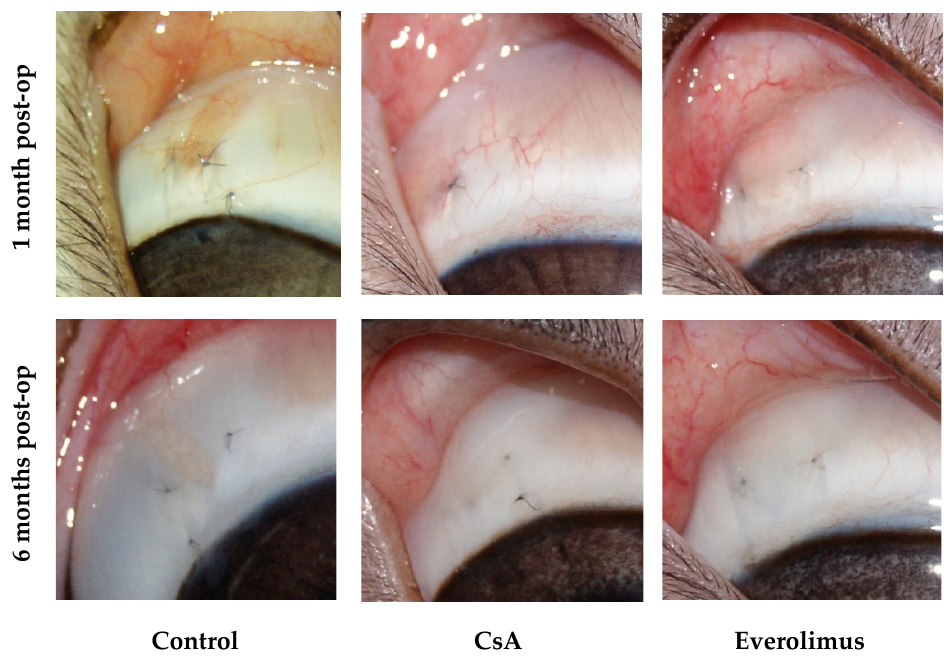
Figure 11. Anterior segment of rabbit eyes one and six months post-op. Surgery area.